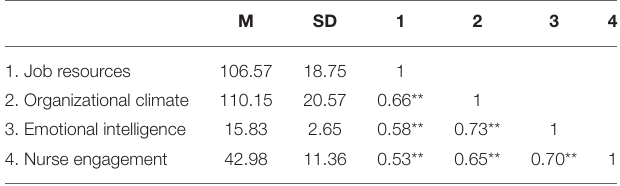
TABLE 1 | Descriptive statistics and correlation analysis of